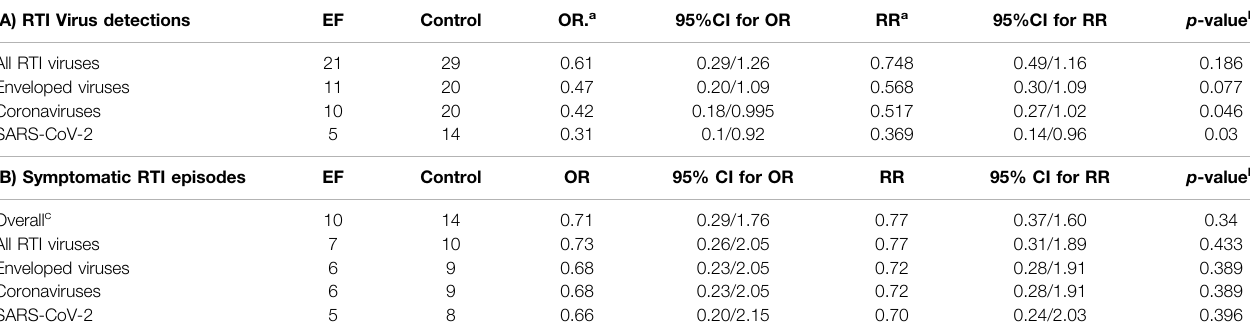
TABLE 2 | Incidences of RTI virus detections (A) and symptomatic RTI episodes (B) during phases of prevention. (A) RTI Virus